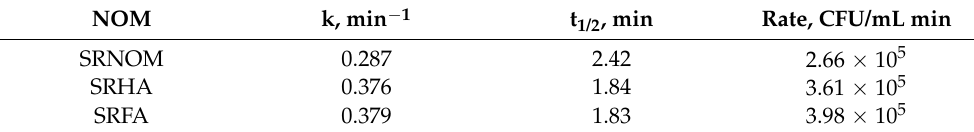
Figure 1. SPCI profile of E. coli using LF in the presence of NOM analogue compounds. Table 1. SPCI of E. coli in the presence of NOM analogue compounds: kinetic parameters. NOM k, min −